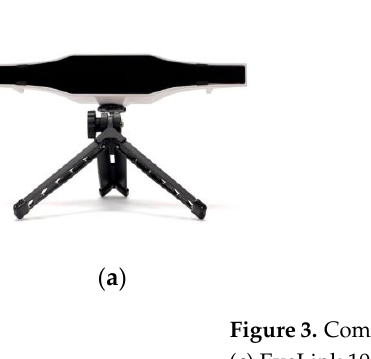
(c) Figure 4. Commercial data gloves for gesture recognition: ( a ) MoCap Pro Glove [132]; ( b ) Cyber Glove [133]; ( c ) Vrtrix Glove [134]. The vision-based device is less constrained and moves more naturally than the sen- sor-based one, and does not require users to wear anything over the hands. This device is relatively cheap, simple, natural ,and convenient to use in the application of CAD. At pre- sent, representative vision-based products used in the process of CAD are Kinect and Leap Motion, as shown in Figure 5. Vinayak [45] developed a novel gesture-based 3D modeling system and used Kinect to complete the recognition and classification of human